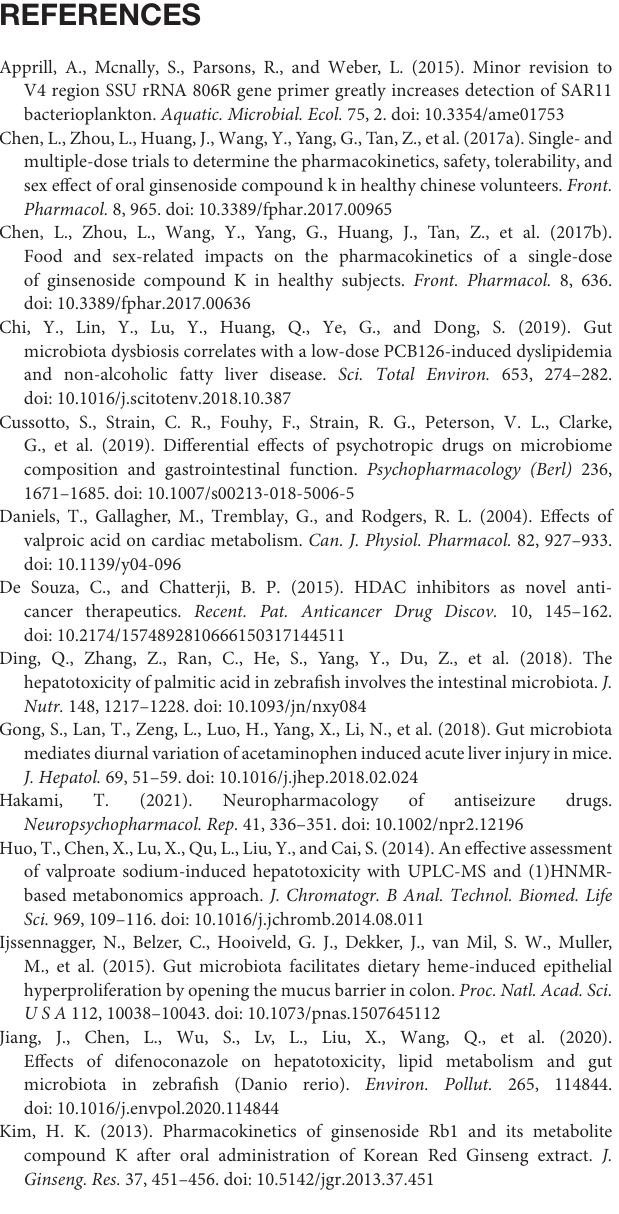
Supplementary Table 2 | Statistics values for relative abundance of bacterial class. Supplementary Table 3 | Statistics values for relative abundance of bacterial order. Supplementary Table 4 | Statistics values for relative abundance of bacterial family. Supplementary Table 5 | Statistics values for relative abundance of bacterial genus. Supplementary Table 6 | Statistics values for relative abundance of bacterial